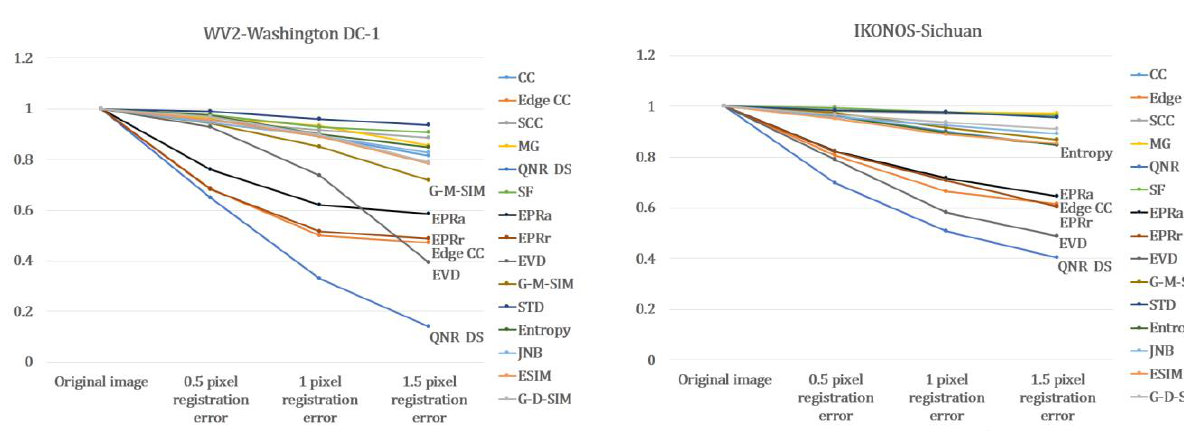
Figure 9. Comparative charts of metrics on data 1.